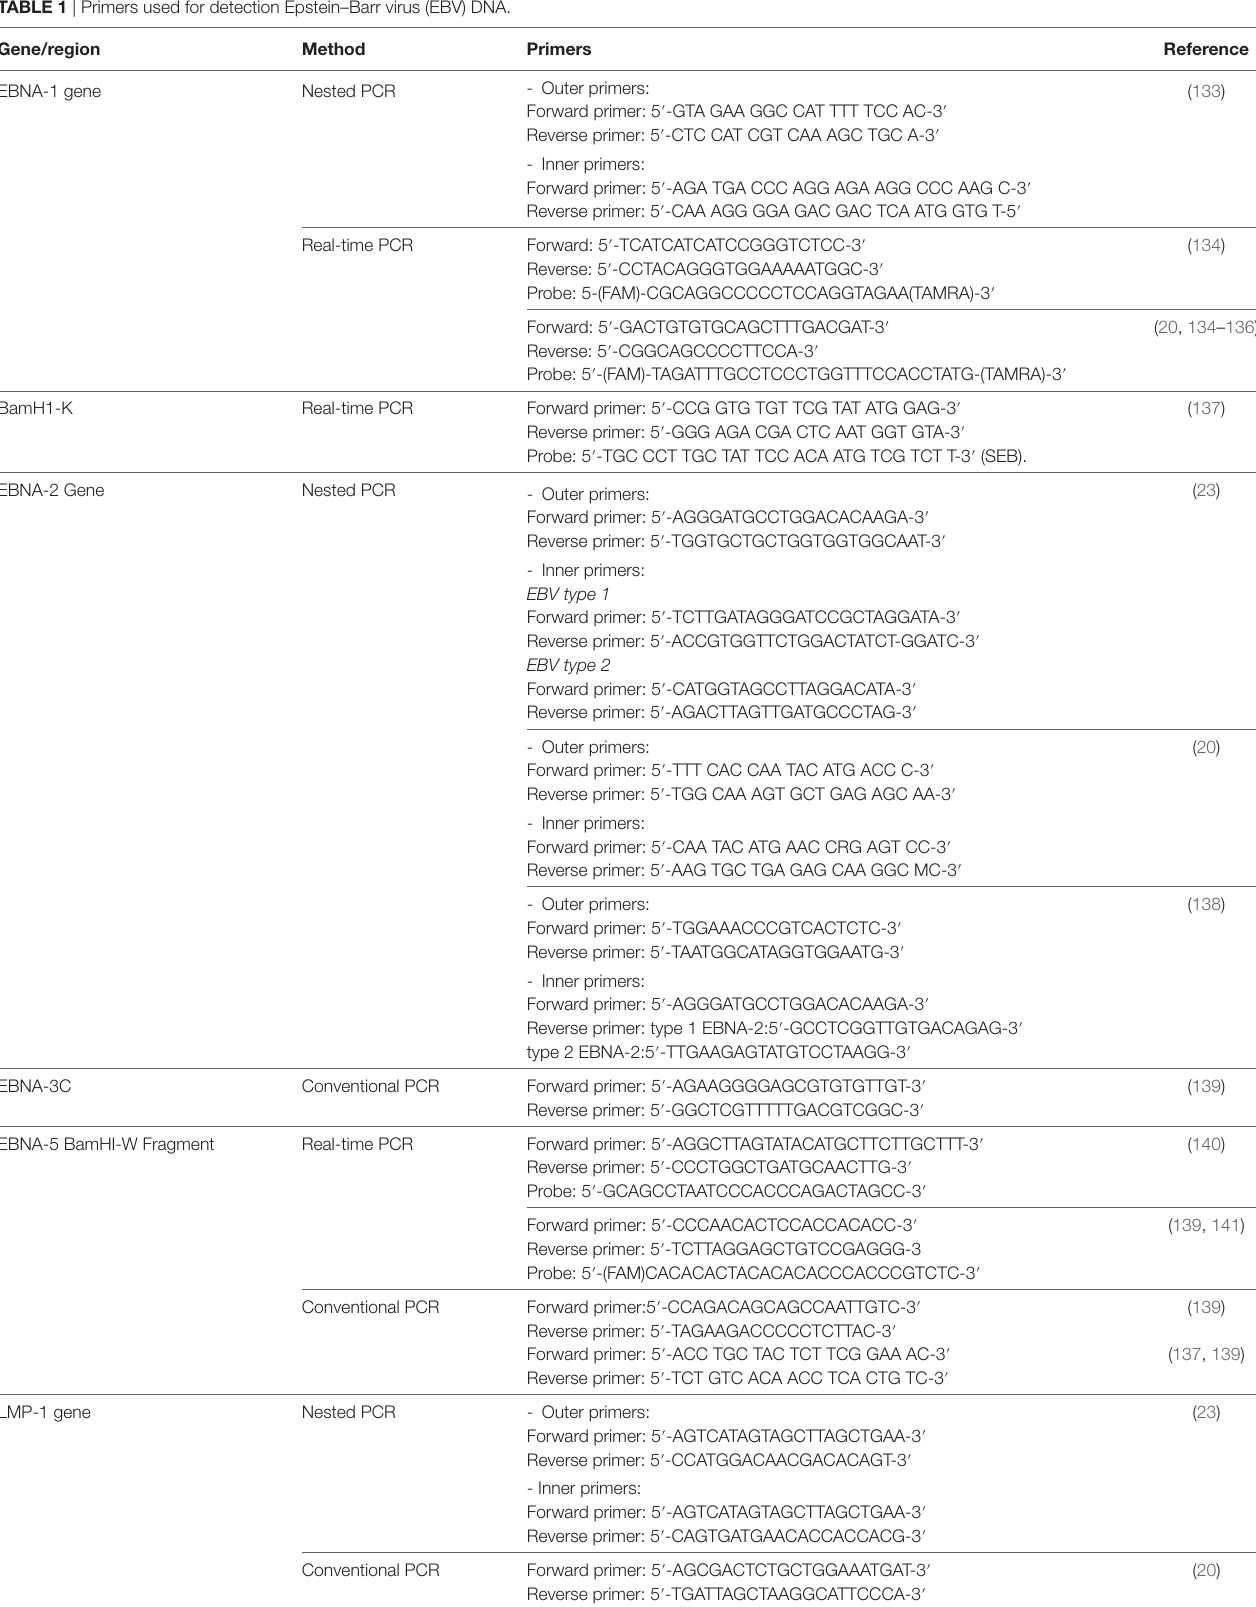
TABLe 1 | Primers used for detection Epstein–Barr virus (EBV)